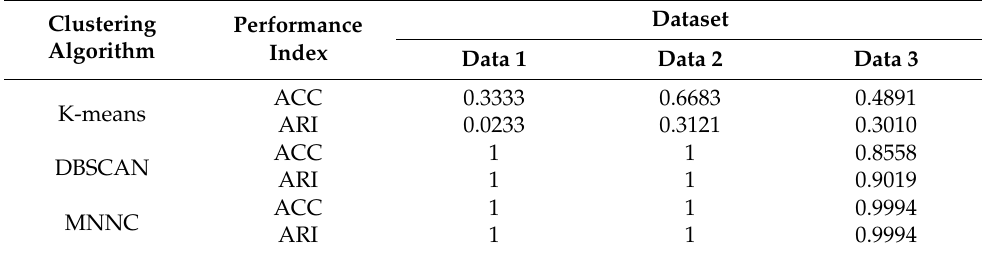
Table 1. Clustering index of the clustering